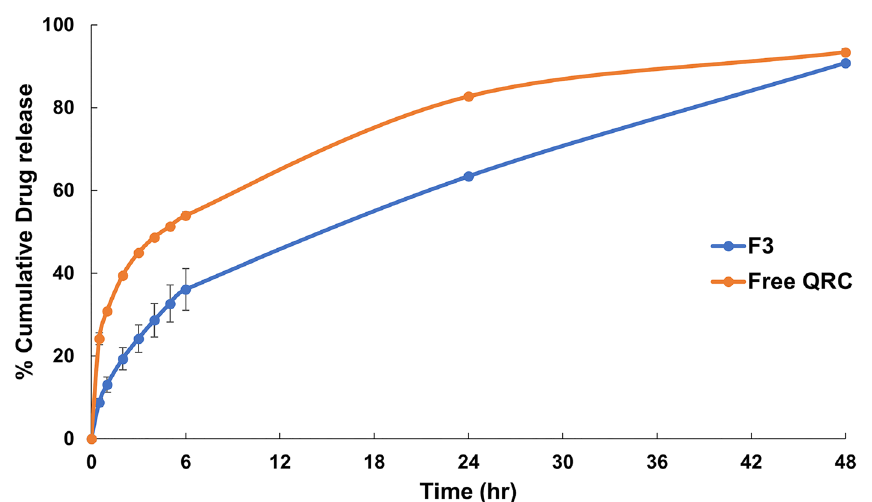
Figure 5. In vitro release profile of free QRC and F3.